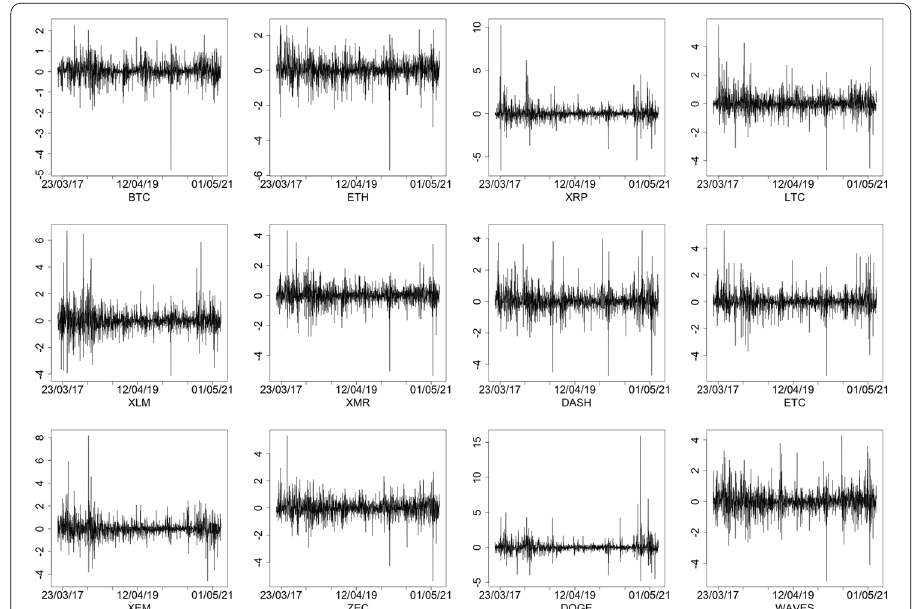
Fig. 3 Dynamics of the 12 CCs’ log return